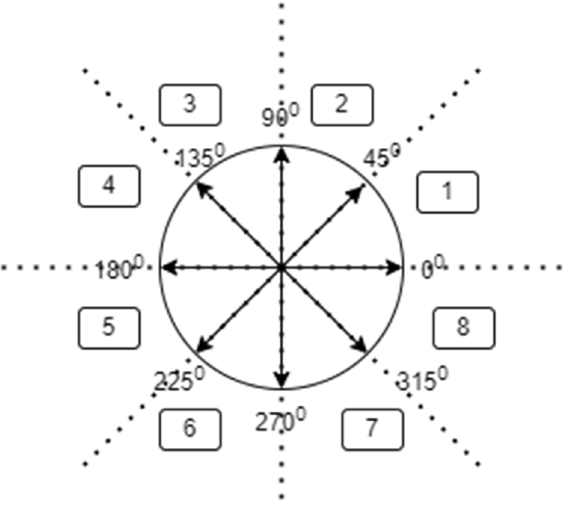
Figure 3. Eight existing directions.